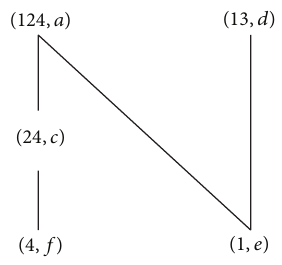
Figure 5: (𝐻 𝑚 ,≤) of (𝐺, 𝑀, 𝐼) in Table